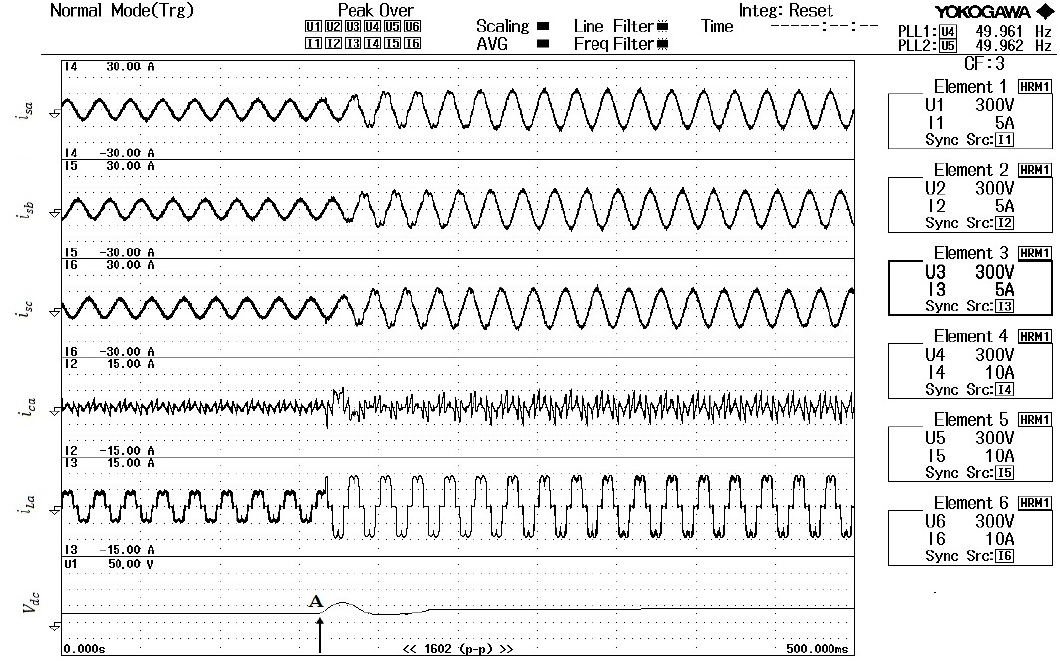
Figure 14. Performance of the compensator for time-varying current source type nonlinear load.